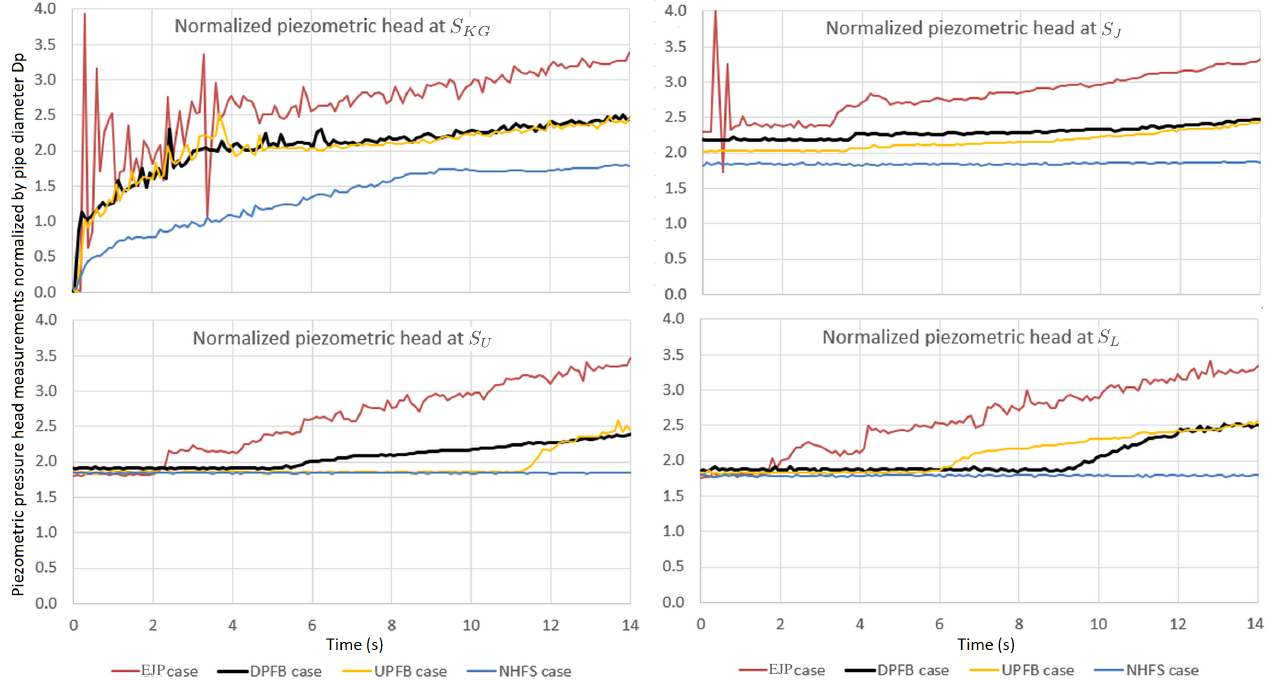
Figure 9. Representative pressure results for different types of the observed junction pressurization, grouped by the location of the pressure